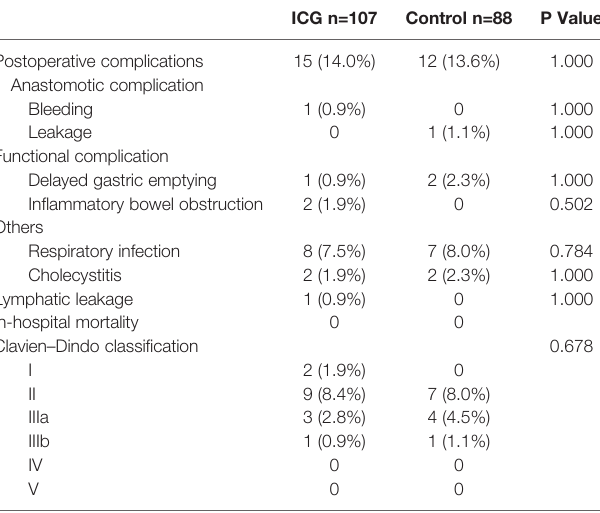
TABLE 3 | Postoperative complications of ICG and control group.